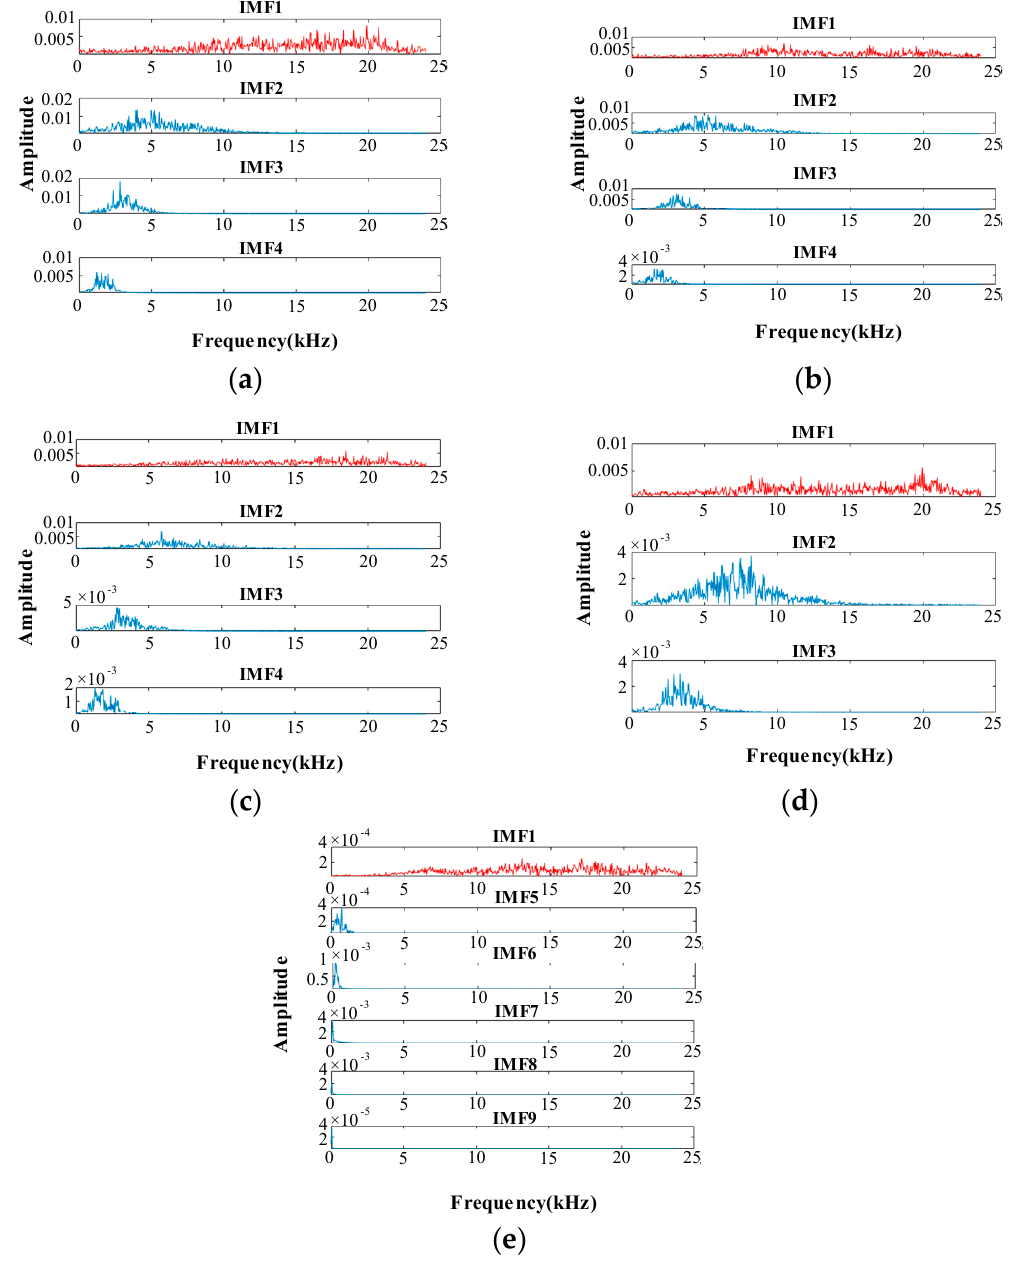
Figure 11. The various effective IMF component spectra of DN20. (a) 0.30 MPa; (b) 0.25 MPa; (c) 0.20